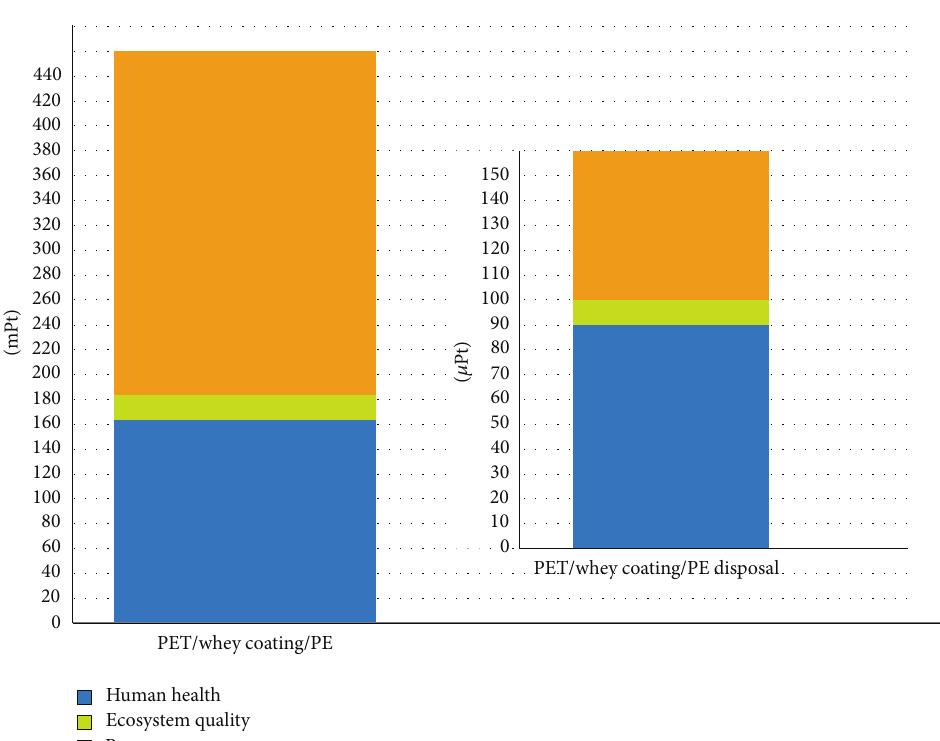
Figure 5: Environmental damage for PET/whey coating/PE films and magnified impact of the whey-coating disposal.